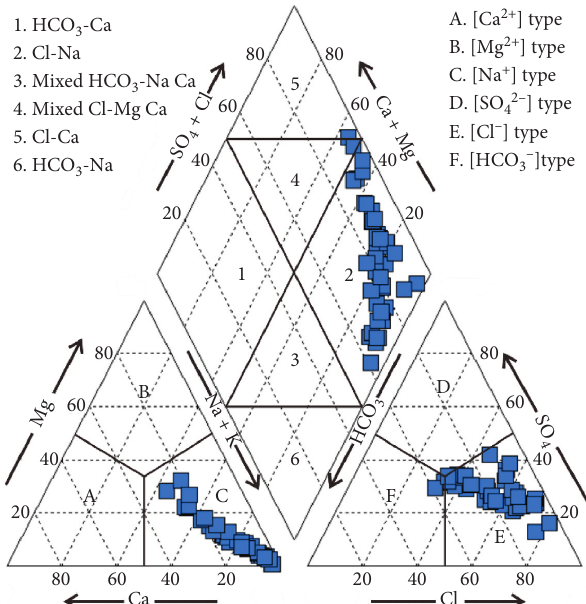
Figure 5: Piper diagrams demonstrating the hydrochemical compositions of groundwater in the study